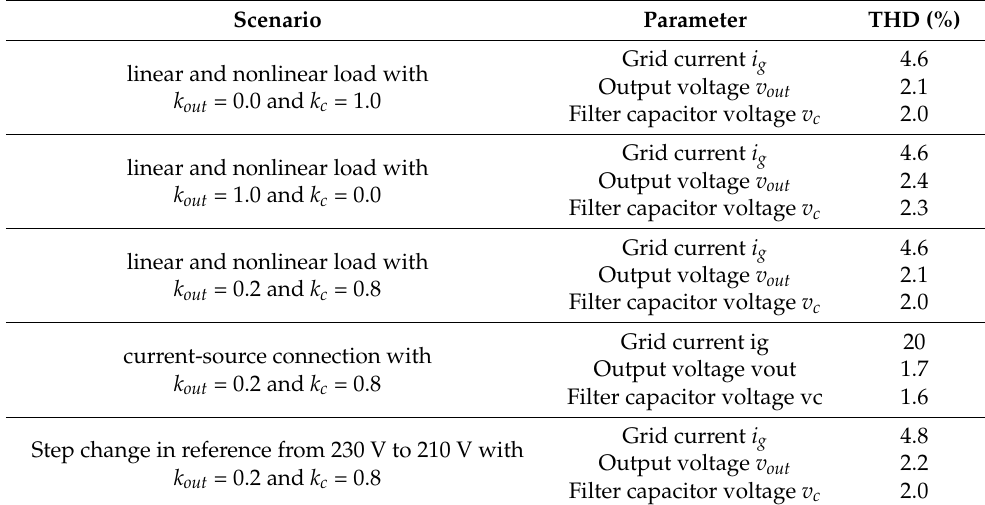
Table 2. Comparison of THD results of the ER parameters for different